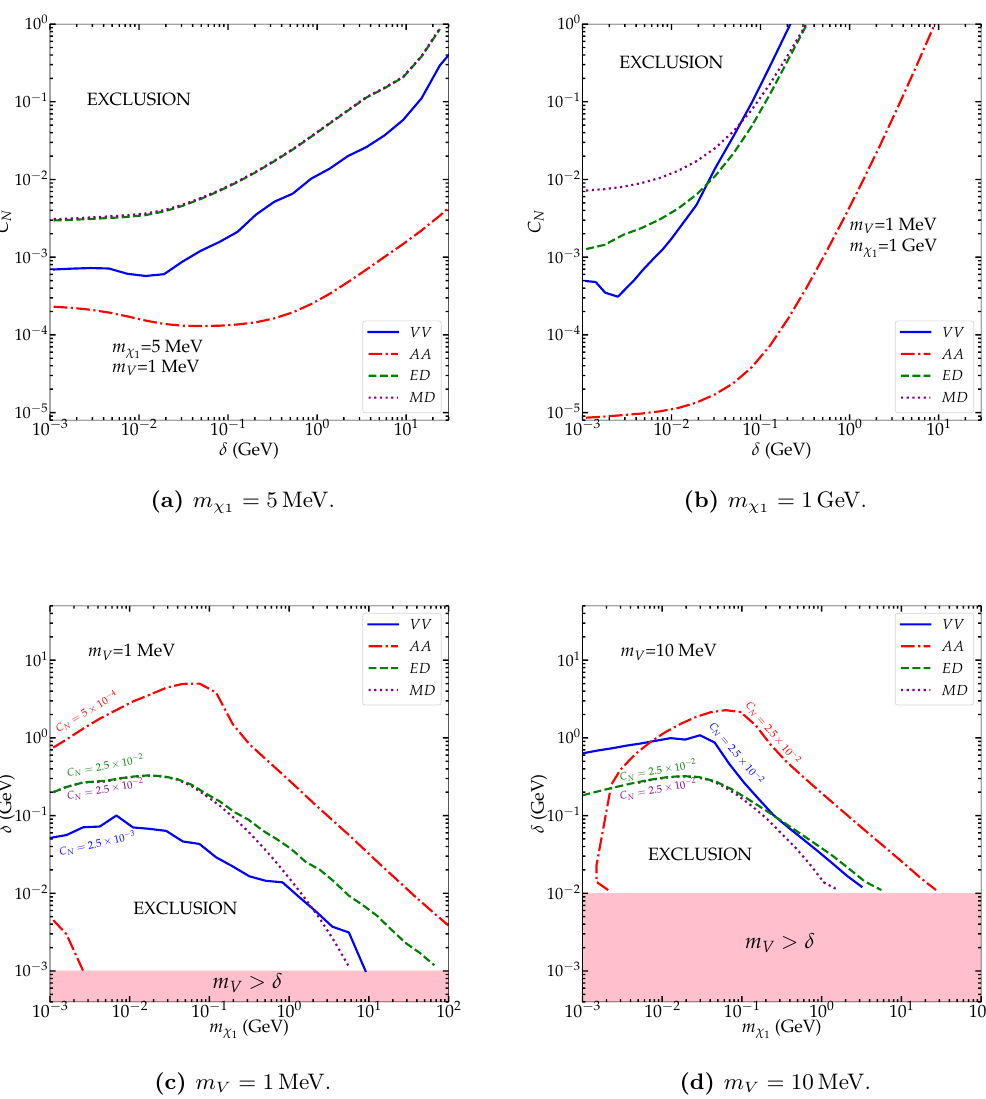
Figure 9. PandaX-4T limits are projected onto the plane ( δ , C N ) [two upper panels] and the plane ( m , δ ) [two lower panels]. The line-of-sight halo integration D χ 1 The benchmark interactions are VV (blue solid lines), AA (red dash-dotted line), ED (green dashed line), and MD (purple dotted line). In panel (a), ED and MD lines overlap. We fixed Λ = 100 MeV for ED and E ( M )